Question: What form of chart is displayed?
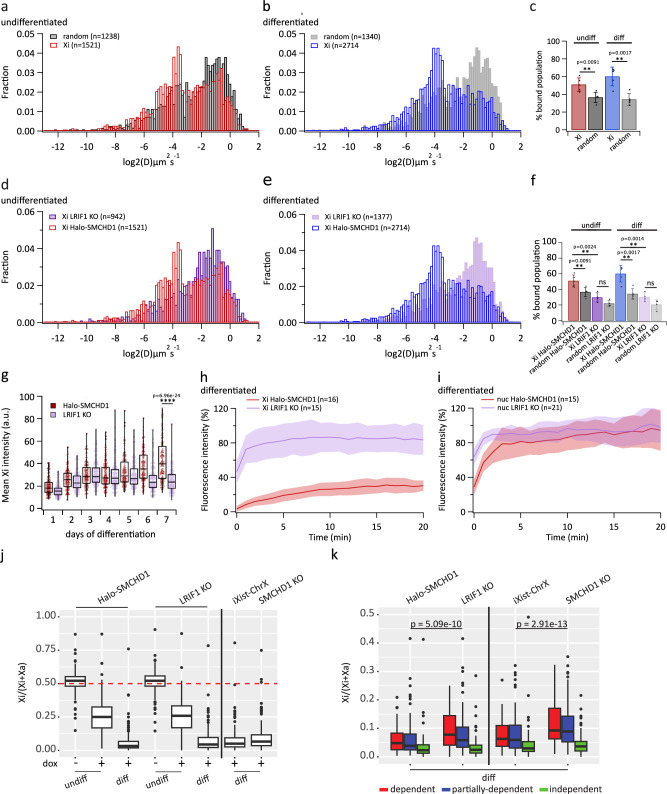
Answer: box